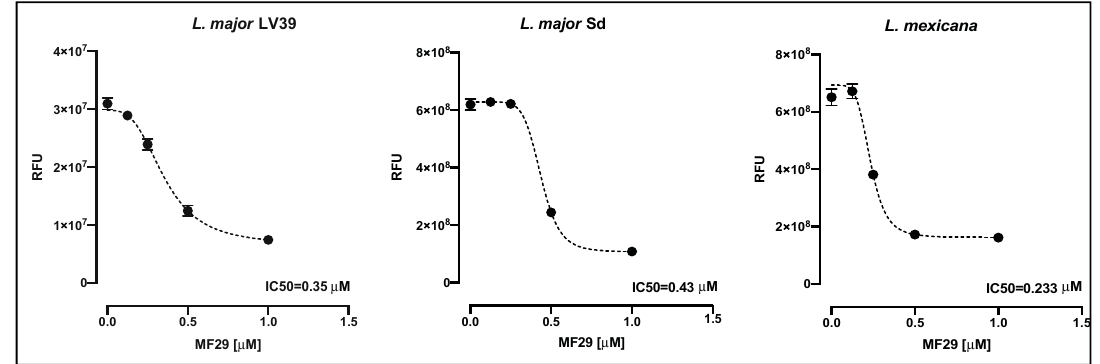
Figure 1. Effect of the MF29 compound against Leishmania species . Metacyclic promastigotes were cultured for 8 h in the presence of MF29 at 1, 0.5, 0.25, and 0.125 μ M concentrations, and the IC 50 was assessed by Alamar blue. The figure is representative of one out of three experiments. Each point represents the mean ± SEM ( n = 3 per group).